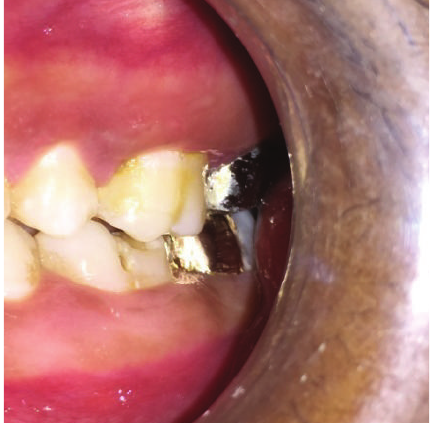
Figure 21: Photograph showing inlay luted with respect to 37 (buccal